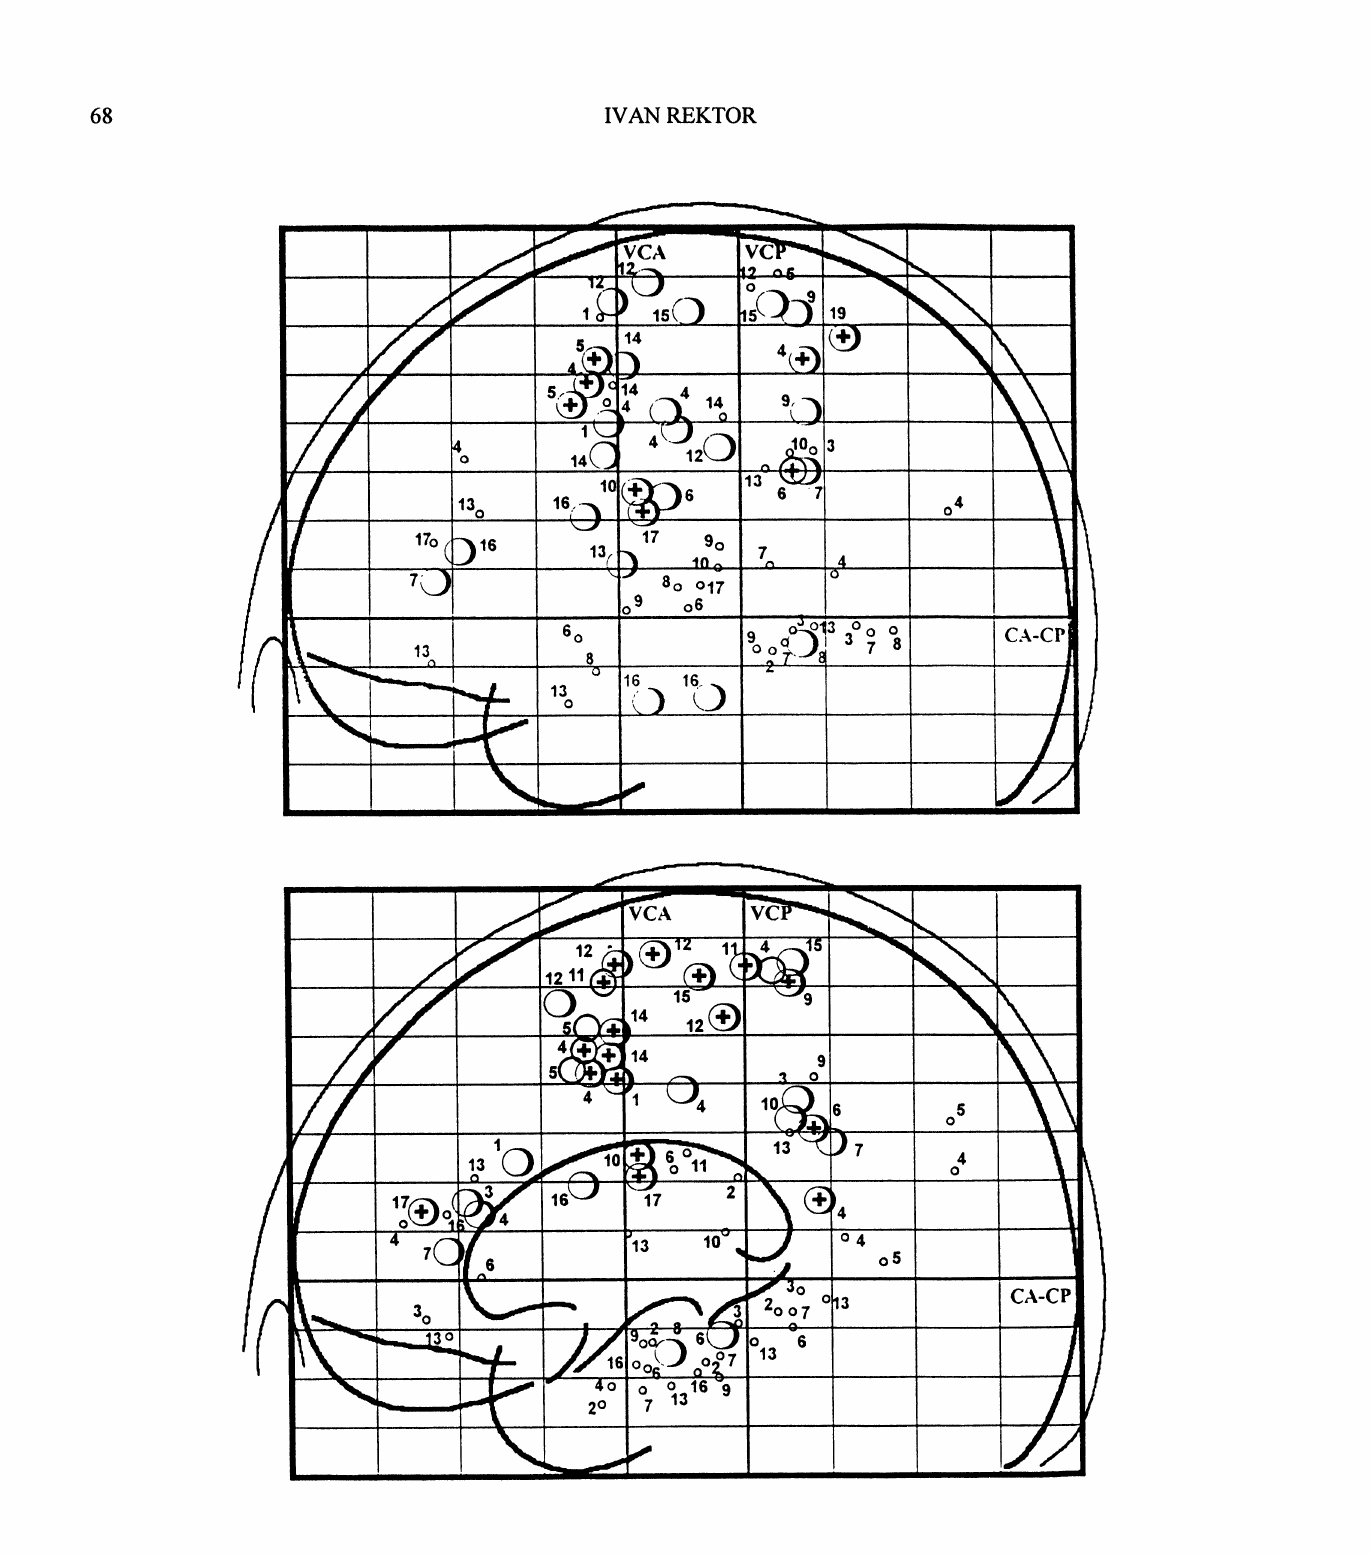
Fig. 2: The cortical recording sites in the Readiness Potential paradigm. Upper part: Lateral view of the brain. Lower part: Sagittal aspect. In the supracallosal part the internal contacts of multilead electrodes mostly reached the mesial wall. In the lower part of the diagram some of the recording points correspond to sites located more laterally. This schema presents the results in one or in both hemispheres. The numbers correspond to the individual patients. The large circles show the MASP occurrence. They are crossed if a Readiness Potential preceded the MASP. The small circles indicate electrodes which recorded no slow potential. Reprinted from: Rektor I. et al. Electroencephalogr olin Neurophysiol, 1998; 107:277 286, with permission from Elsevier